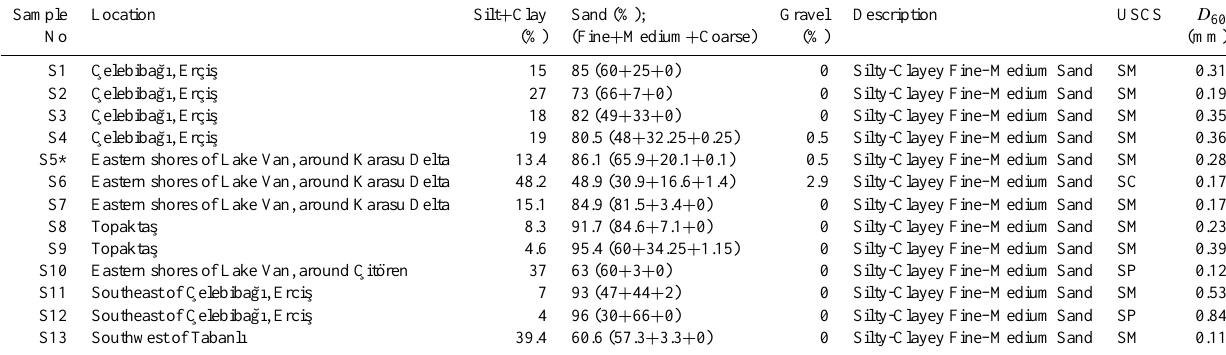
Fig. 13. Grain size distribution curves of liquefied soil samples. Table 2. Grain size distribution test results for the liquefied 12 soil samples and 1 soil sample (S5*) taken from a landslide body. Sample Location Silt + Clay Sand (%);